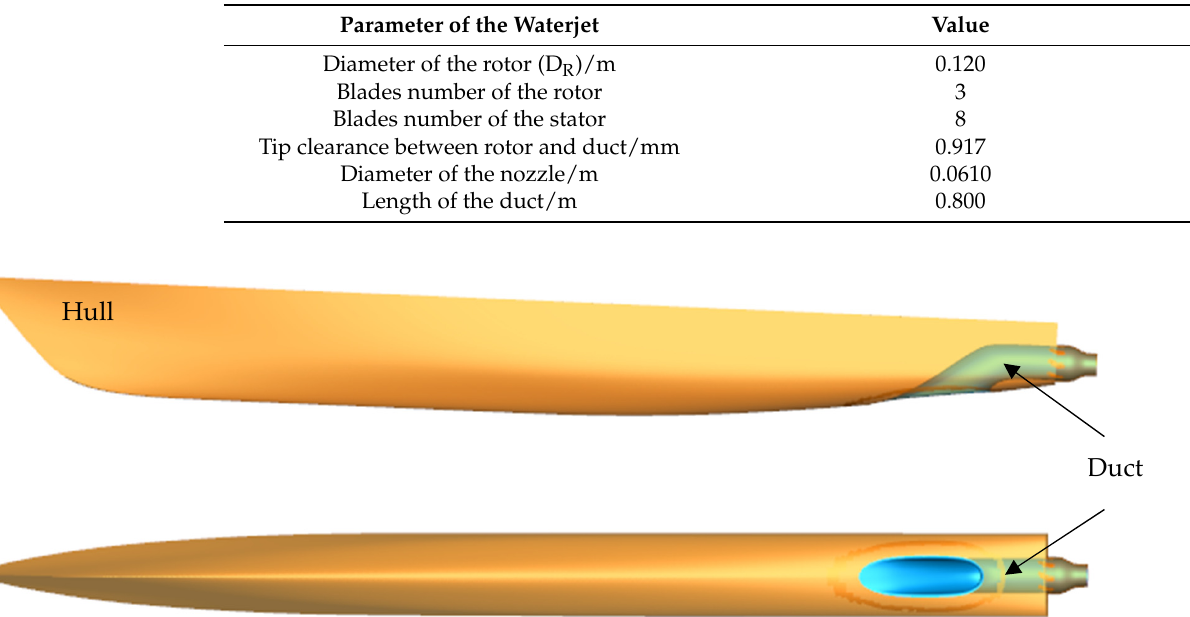
Table 2. Geometry parameter of the waterjet.